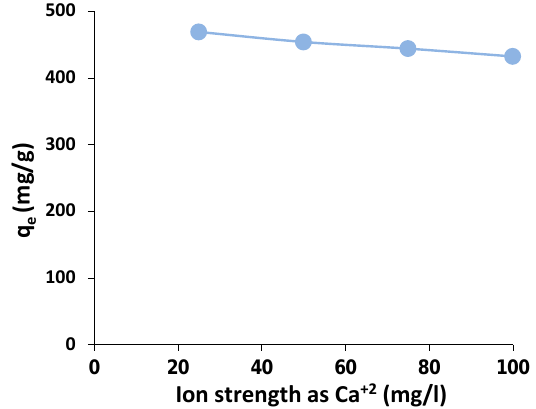
Figure 6. The effect of solution ion strength on sorption